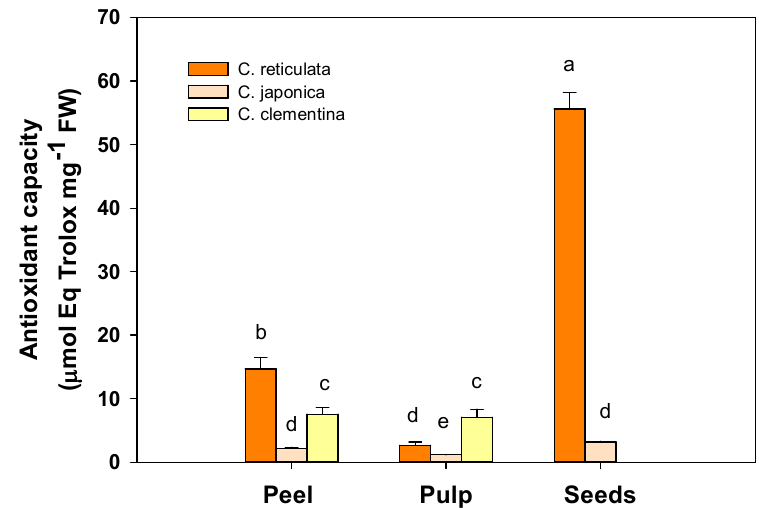
Figure 2. Total antioxidant capacity of peel, pulp and seeds in the three di ff erent mandarin cultivars: C. reticulata (Phlegrean mandarin), C. japonica (Kumquat) and C. clementina (Clementine). Each bar represents the mean ± SE ( n = 6). Di ff erent letters indicate statistically significant di ff erences among mandarin varieties ( p < 0.05). Results were analysed by one-way ANOVA followed by Holm–Sidak post hoc test for multiple comparisons.